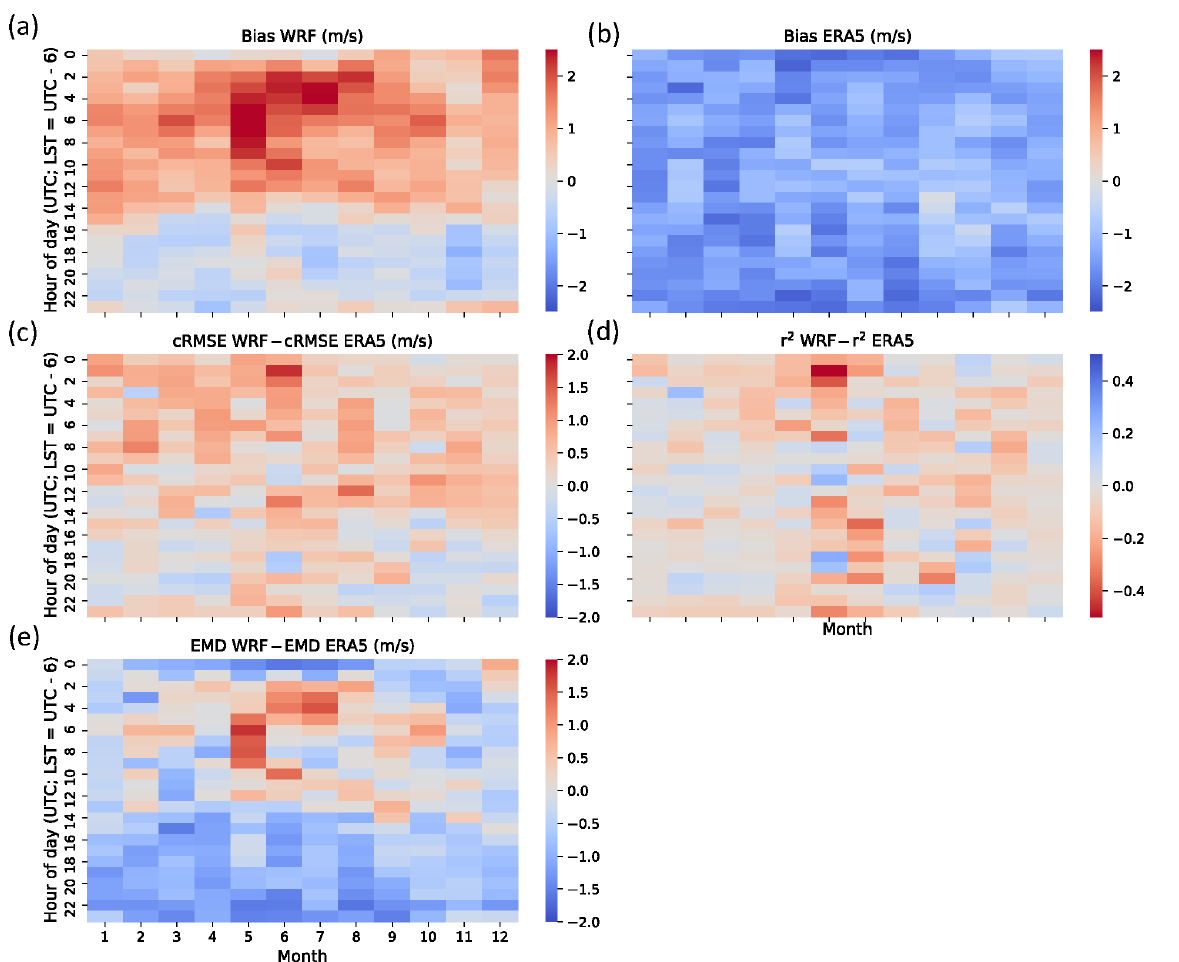
Figure 9. The 24 × 12 heat maps at the SGP C1 site showing the diurnal and seasonal variability in bias, cRMSE, r 2 , and EMD for the 91m wind